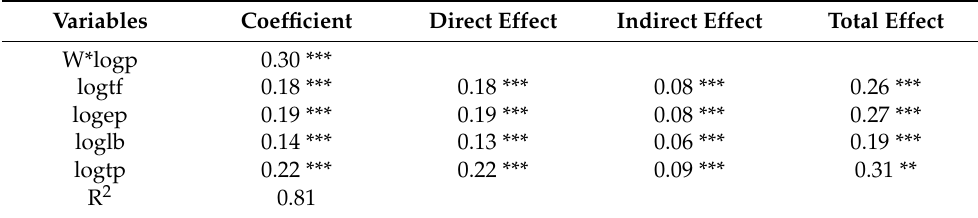
Table 4. Results of the SLM with spatial fixed effects for the 35 large and medium-sized cities in China. Variables Coefficient Direct Effect Indirect Effect Total Effect W*logp 0.30 *** logtf 0.18 *** 0.18 *** 0.08 *** 0.26 *** logep 0.19 *** 0.19 *** 0.08 *** 0.27 *** loglb 0.14 *** 0.13 *** 0.06 *** 0.19 *** logtp 0.22 *** R 2